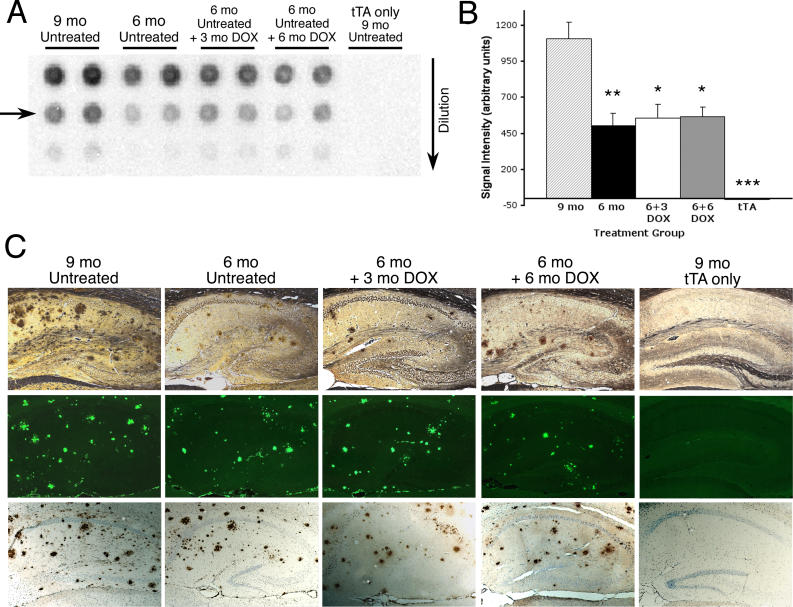
Suppression of Transgenic APP Arrests Progression of Amyloid Pathology(A) Aggregated Aβ was quantified in cortical tissue from dox-treated and control tTA/APP mice (line 107) using a filter trap assay. Serial dilutions of protein homogenate were passed through a cellulose acetate filter; protein aggregates larger than the pore size were trapped and immunostained for Aβ.(B) Quantitation of signal intensity in the linear range of each filter trap dilution series (arrow in [A]) was used to compare aggregate load across treatment groups. Aggregated Aβ increased significantly between 6 and 9 mo of age in untreated mice (significant effect of group ANOVA F
3,18 = 7.85, p < 0.002). This progression of pathology was completely prevented by transgene suppression. The amount of aggregated Aβ was identical in untreated mice at 6 mo of age to that in 9- or 12-mo-old animals treated with dox (p > 0.9, Tukey post-hoc test). Single transgenic tTA samples were included as negative controls and showed no signal above background. *, p < 0.01; **, p < 0.005 versus 9-mo-old untreated mice, Tukey post-hoc test; ***, p < 0.001 versus 9-mo-old untreated mice, Student's t-test.(C) Amyloid pathology in the hippocampus of representative mice from each treatment group: Hirano silver stain (top row), thioflavin-S (middle row), and Aβ immunohistochemistry (bottom row). Amyloid burden increases dramatically between 6 and 9 mo of age in untreated animals, but remains stable in transgene-suppressed mice over the same period (6 mo + 3 mo dox and 6 mo + 6 mo dox). Single transgenic animals (tTA only shown here) show no sign of amyloid pathology at any age tested.